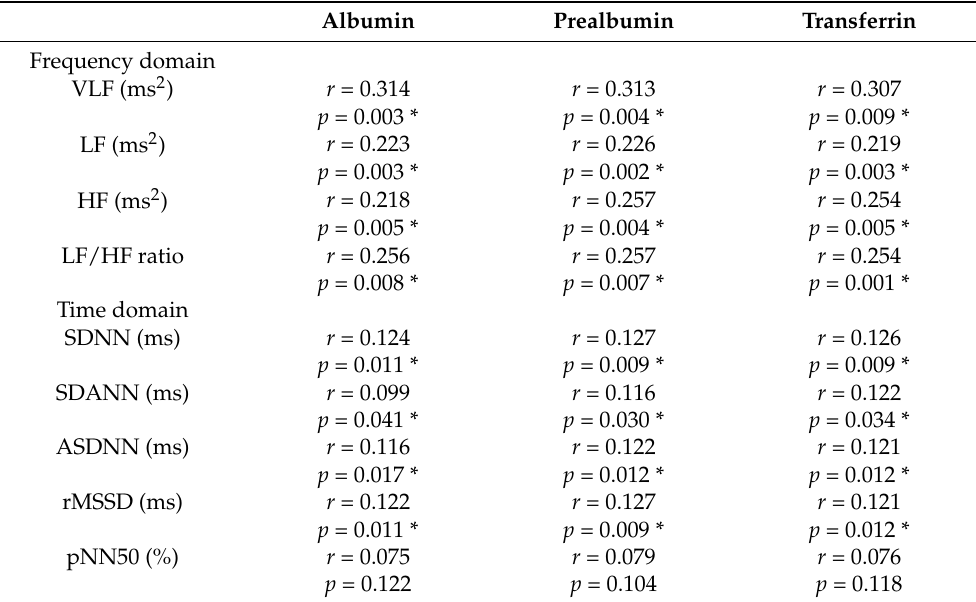
Table 5. Correlation analysis of serum albumin, prealbumin, and transferrin levels with the HRV pa- rameters.